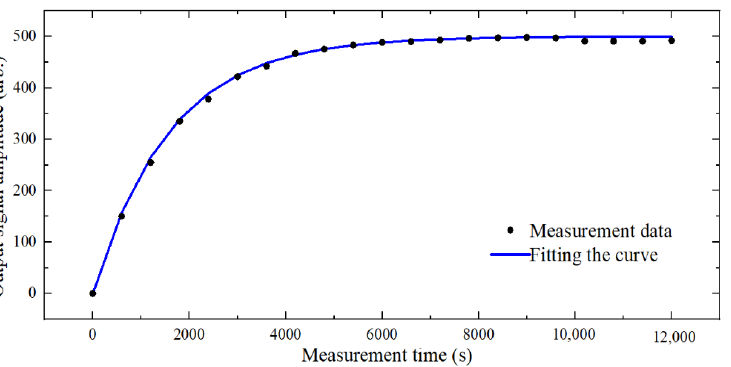
Figure 6. Experimental measurement of longitudinal relaxation rate of inert atoms in strongly cou- pled spin ensemble without magnetic field gradient.